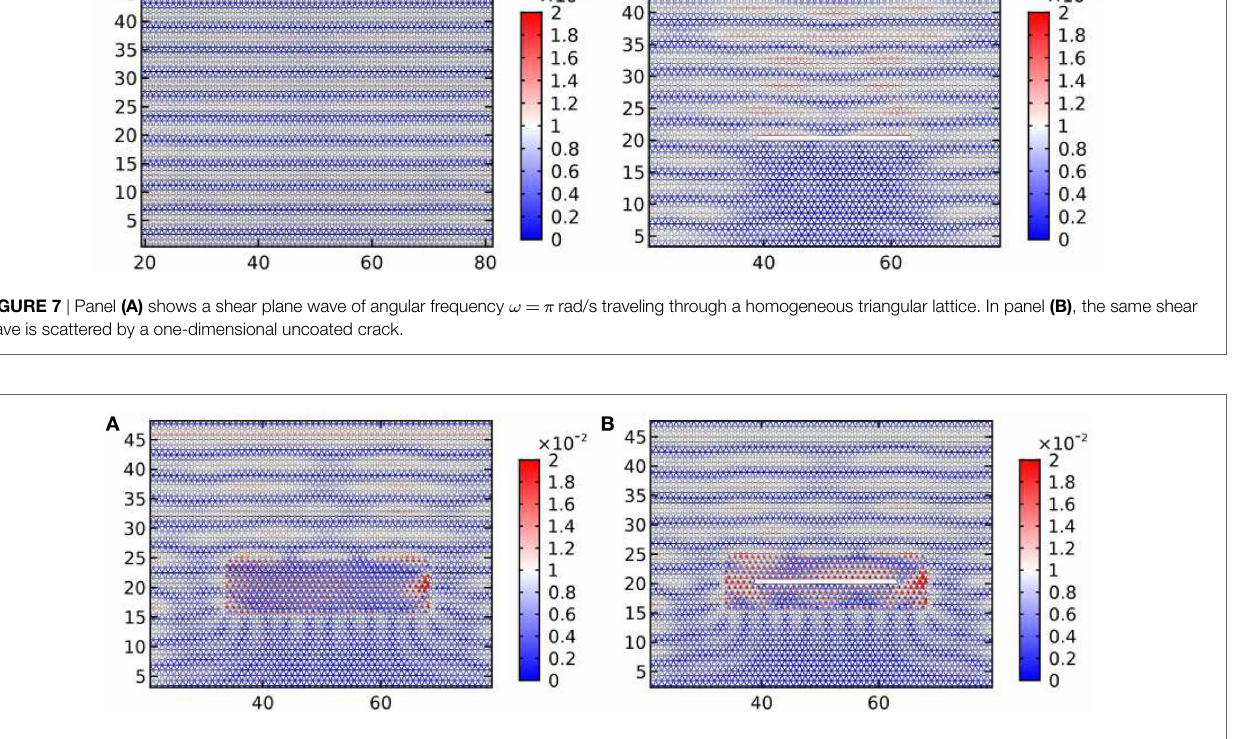
FIGURE 8 | The harmonic responses to a shear plane wave of frequency ω = π rad/s corresponding to the Dirac-like point for the TLR. Panels (A,B) represent a cluster of resonators and a crack surrounded by a cluster of resonators, respectively. The parameters used to model the clusters are listed in set 1 of Table 1 .